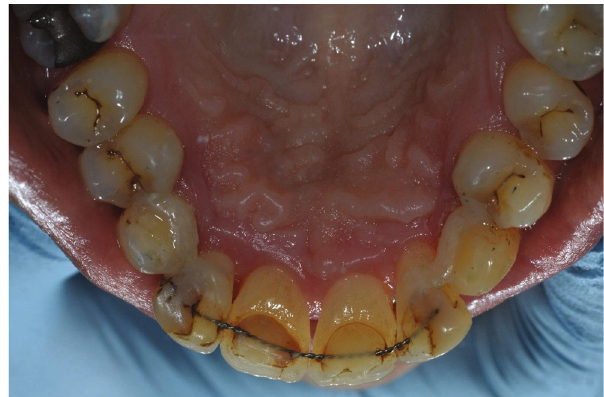
Figure 9: Clinical case: occlusal view, lower jaw, orthodontic therapy.